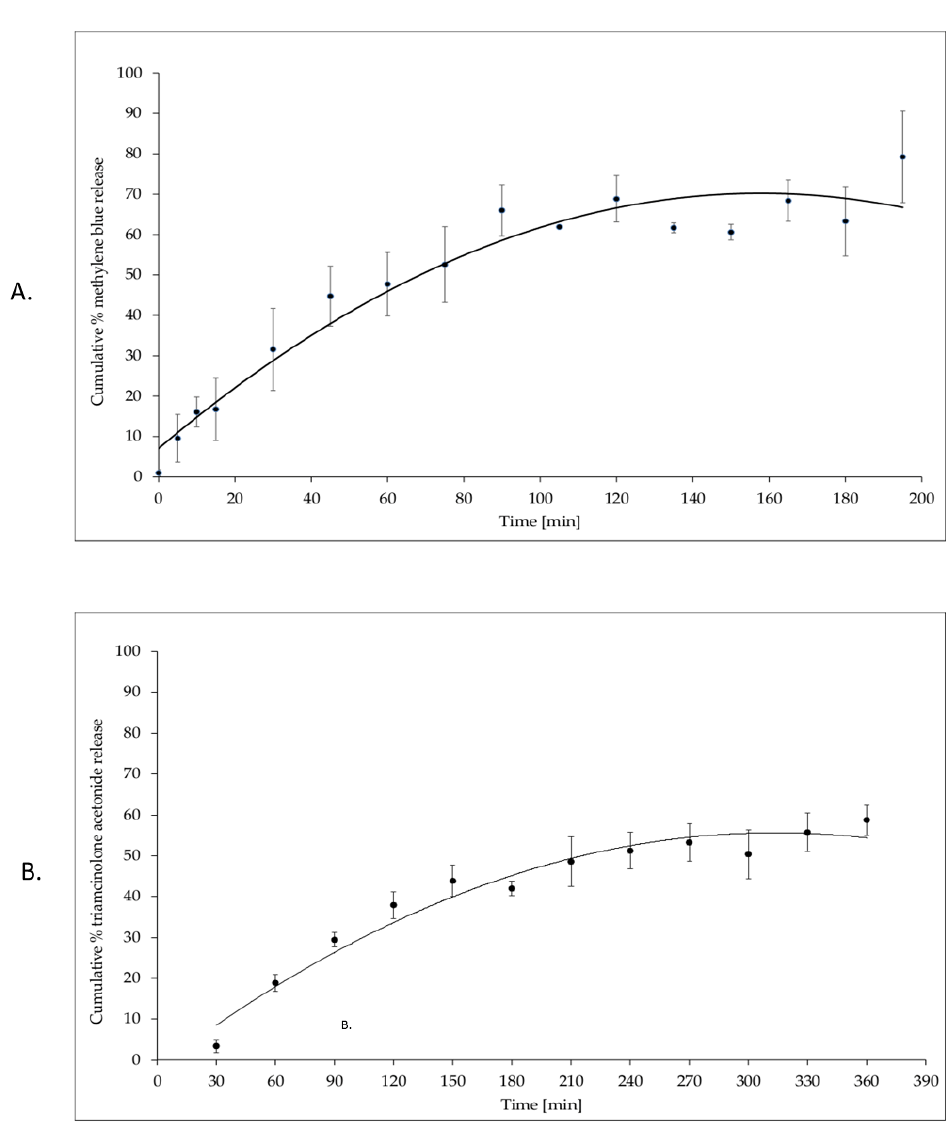
Figure 8. ( A )—In vitro cumulative methylene blue release profile of from porous matrix containing 93.5 mg/cm 2 methylene blue in dry mass. Results represent mean ± SE, n = 3. ( B )—In vitro cumulative triamcinolone acetonide release profile of from porous matrix Pul40/Alg containing 0.05% substance in dry mass. Results represent mean ± SE, n = 3.